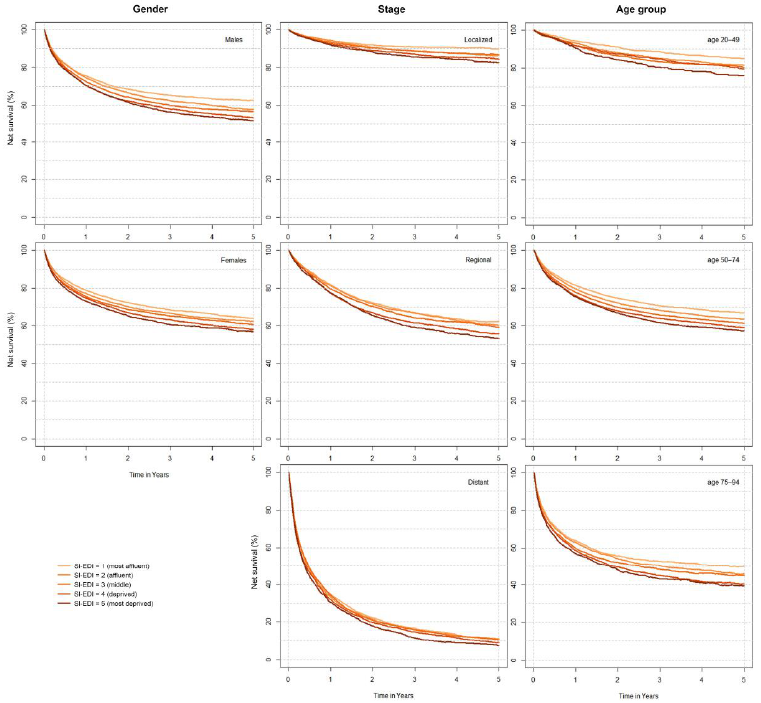
Figure 2. Net survival by Slovenian deprivation index (SI-EDI) and by gender, stage, and age group at diagnosis, Slovenia 2014−2018.